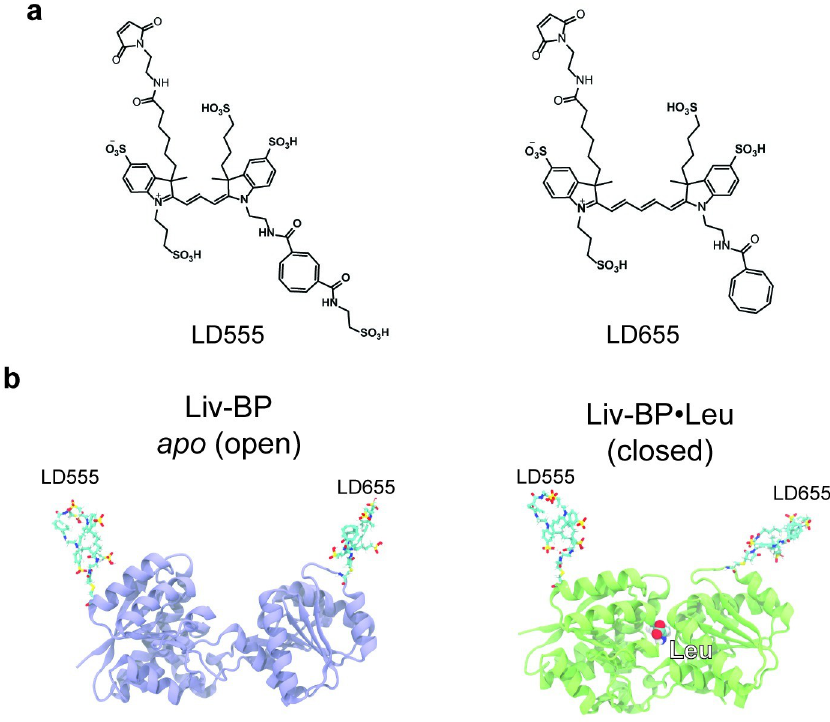
Fig 1. Models of Liv-BP SS conjugated to self-healing fluorophores. (a) Molecular structures of the LD555 and LD655 fluorophores. (b) Conformation of Liv-BP SS in the open ( apo ) conformation–blue, and closed (Leu-bound) conformation–green. For multibasin Gaussian potential simulations the open ( apo ) conformation and the closed (Leu- bound) conformations were set as native states. The models were also used as initial structures for explicit solvent